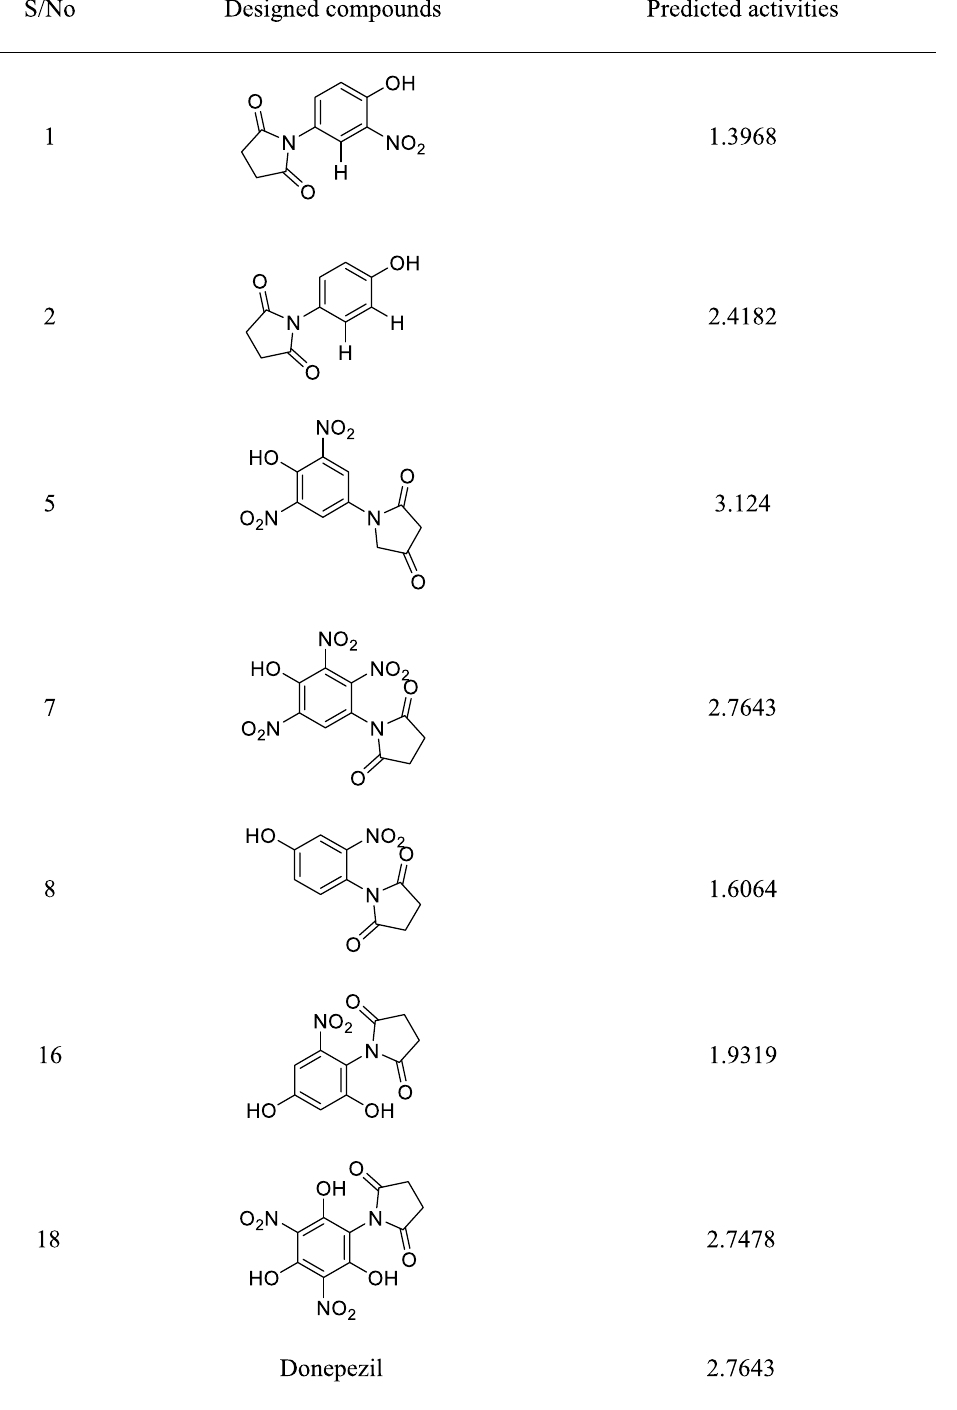
Table 2 Molecular structures of design N -aryl derivatives and their theoretical activities